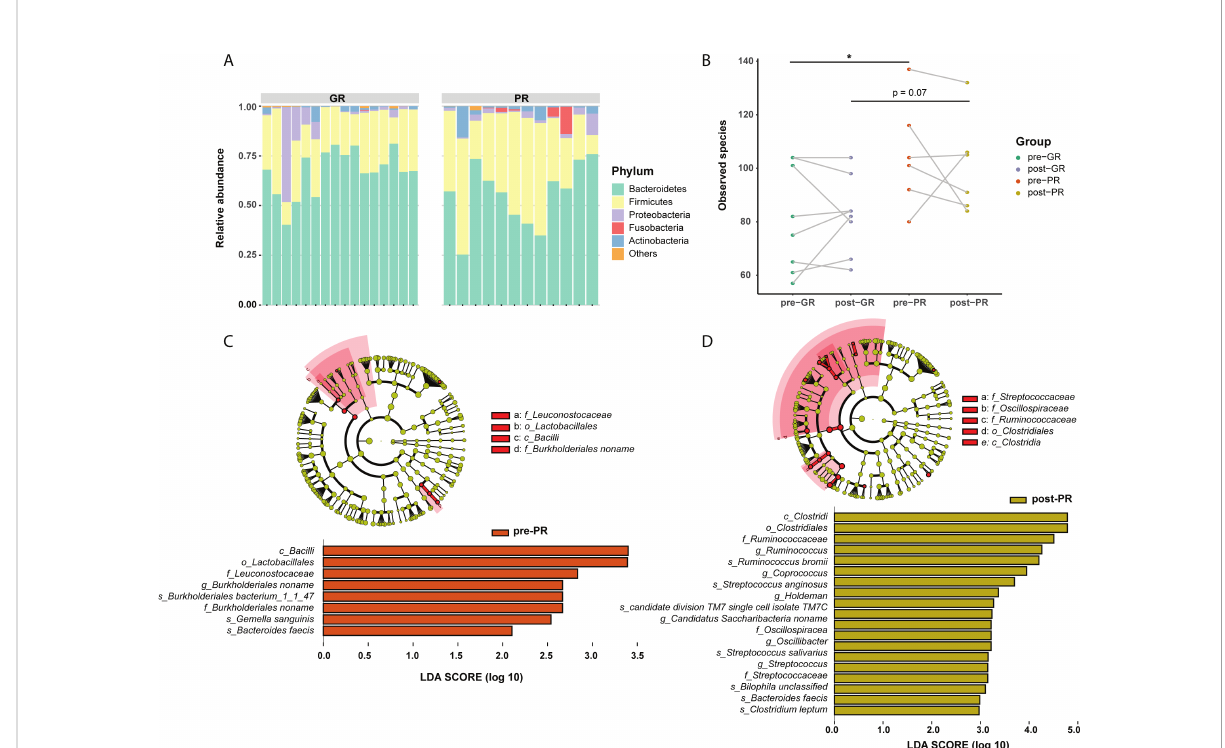
FIGURE 4 Differences in composition of the gut microbiome between the GR and PR groups. (A) Stack plot of phylum composition for each individual. (B) Number of observed species comparison for the four groups. *Student ’ s t -test p < 0.05. (C, D) LEfSe results in baseline samples (C) and post- treatment samples (D) . Signi fi cance is determined by using LDA score ≥